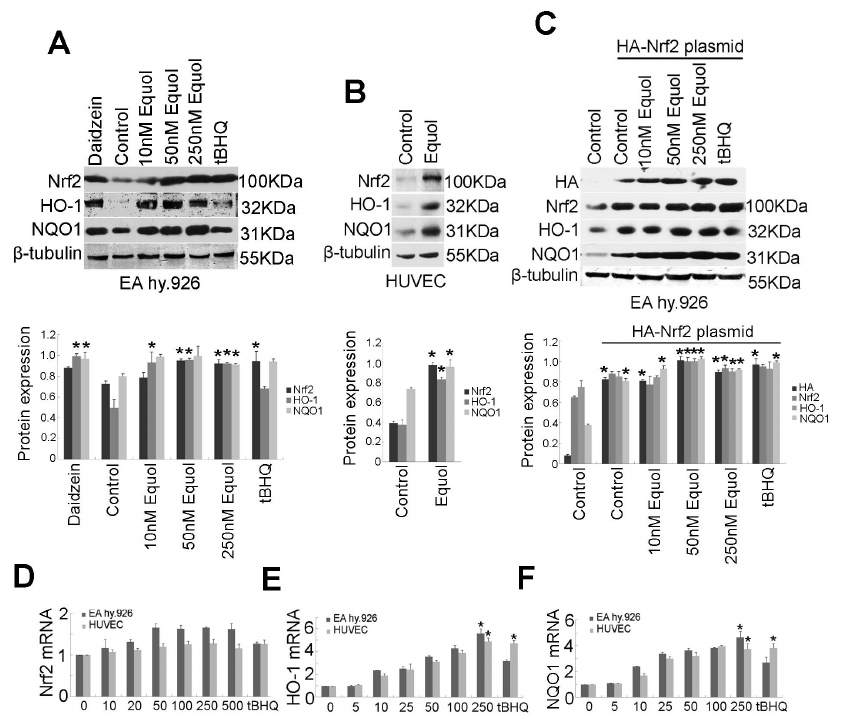
Figure 2. S- (-)equol primarily up-regulated Nrf2 protein expression activating ARE-dependent response. (A) Whole EA.hy926 cells lysates of cells treated with 250 nM S- (-)equol, 500 nM daidzein, or 50 m M tBHQ for 24 h were subjected to immunoblot analysis with anti-Nrf2, anti- HO-1, anti-NQO1, and anti- b -tubulin antibodies. (B) Total HUVECs lysates of cell treated with 250 nM S- (-)equol for 24 h were immunoblotted with anti-Nrf2 and anti- b -tubulin antibodies. (C) EA.hy926 cells were transfected with plasmids containing an HA-tagged Nrf2 open reading frame and the renilla firefly luciferase gene. Medium was changed after 6 hours of incubation. Where indicated, extracts from HA-Nrf2 EA hy.92 cells were additionally probed with anti-HA antibody, anti-Nrf2, anti-HO-1, anti-NQO1 and anti- b -tubulin antibodies. Values are means of three independent experiments with standard deviations represented by vertical bars. Mean values were significantly different compared to controls (* p , 0.05). Total RNA was extracted from EA.hy926 cells or HUVECs treated as indicated, and Nrf2 (D), HO-1 (E), and NQO1 (F) mRNA was measured by real-time RT- PCR analysis. The values shown represent the mean 6 SD obtained for three independent experiments (* p , 0.05).